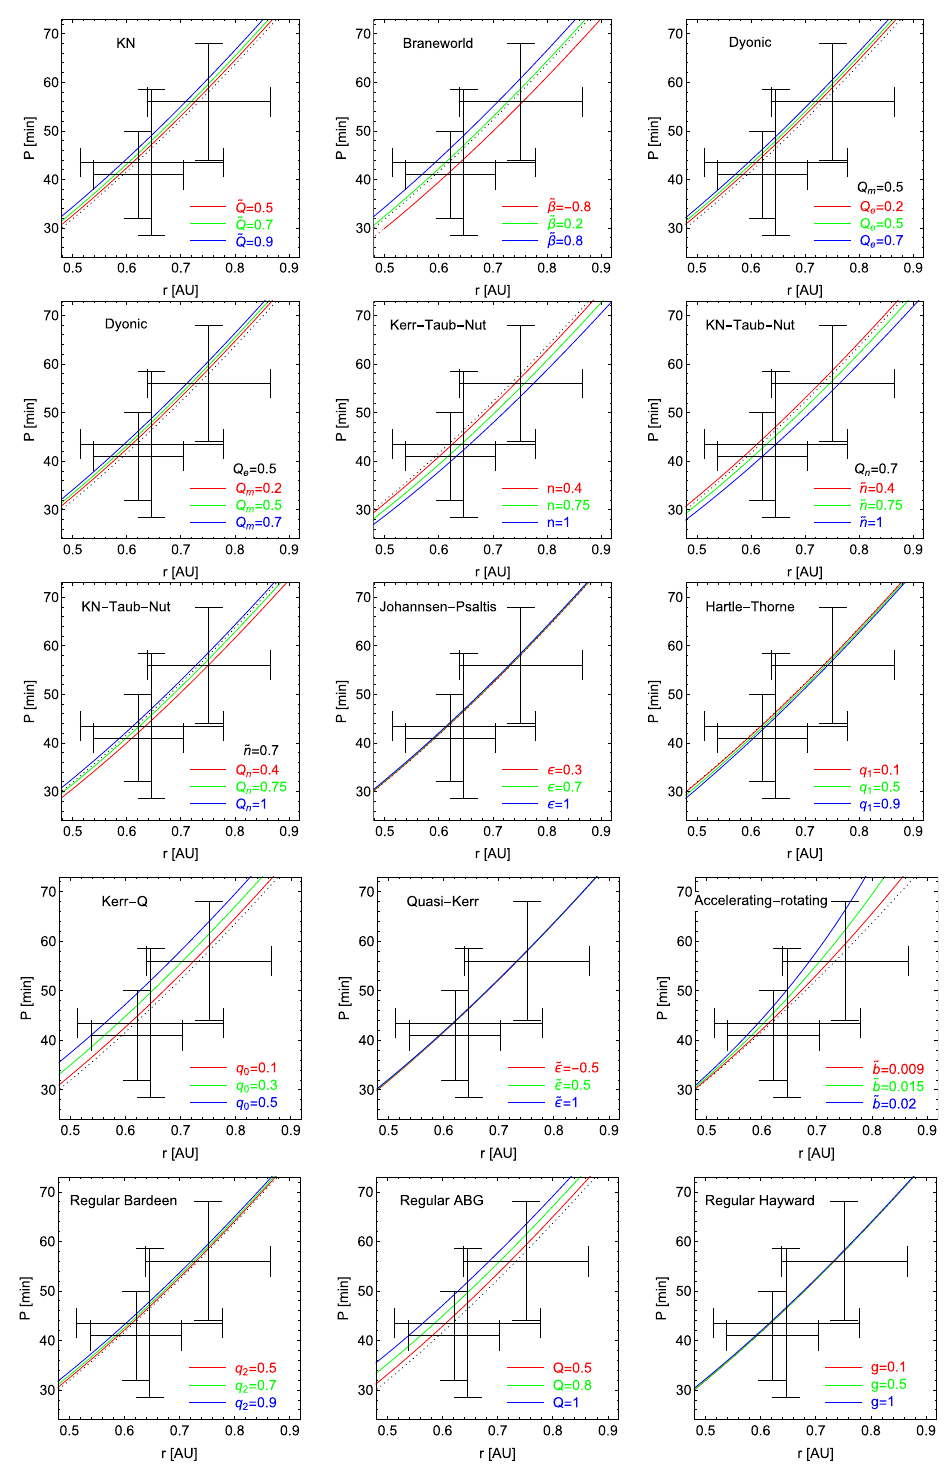
Fig. 2 The relation between orbital period–radius, and position of three flares proposed by GRAVITY on July 22, May 27, and July 28, 2018 fitted with circular orbits of a neutral hot-spot for many different BHs both in GR as well as alternative theories of gravity. We choose the spin parameter a = 0 . 4, and mass M = 4 . 3 × 10 6 M (cid:3) for all BHs. Each plot represents three different orbits fitting the observed positions and periods of three flares. The black dotted curves indicate the Kerr